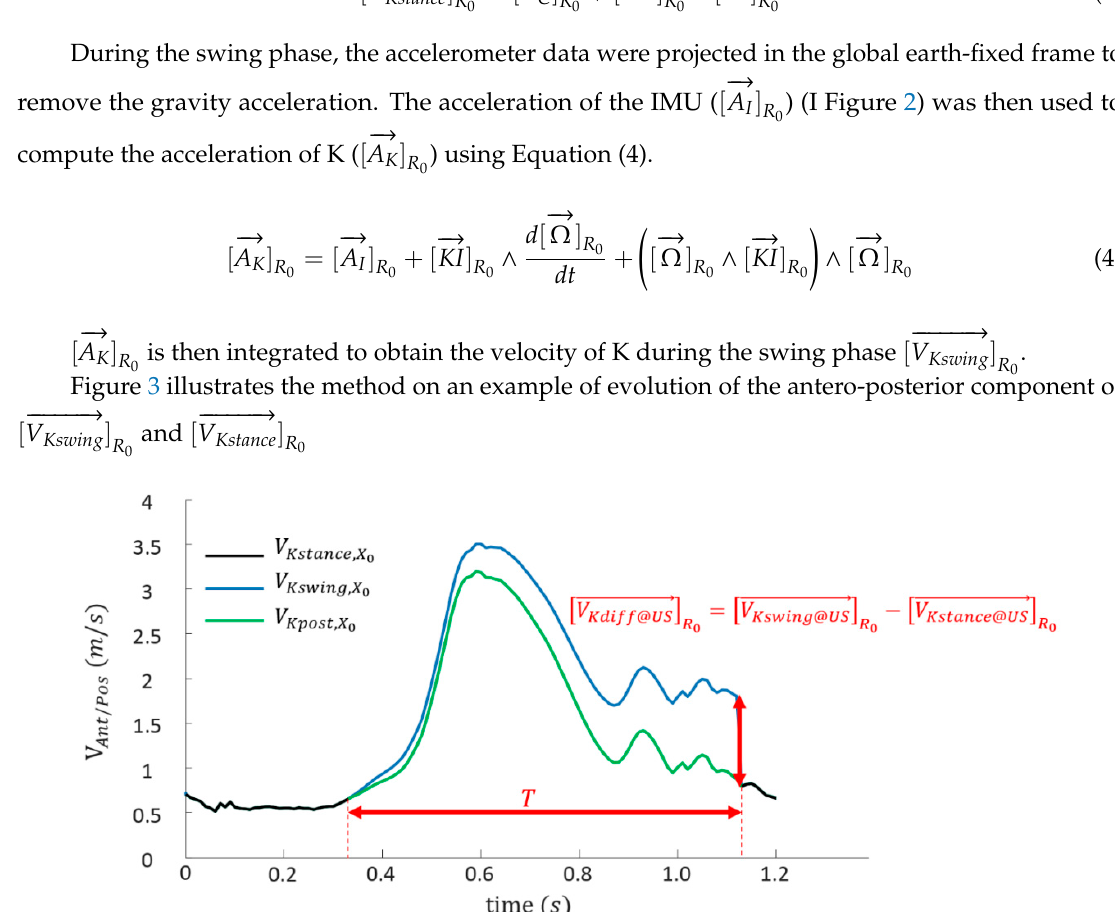
and the effect of a posteriori (cid:3019) (cid:3116)